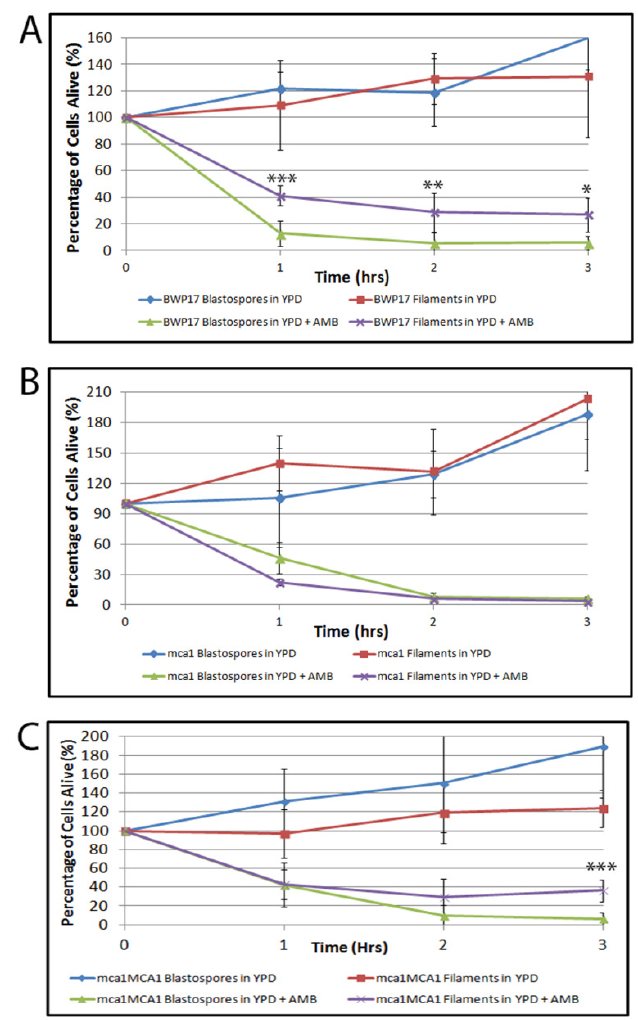
FIGURE 2: Filamentous C. albicans cells are more resistant than blastospores to AMB-induced programmed cell death in an MCA1 -dependent manner. Viability curves compare sur- vival of the following cells exposed to AMB: (A) wild type (BWP17) blastospores and BWP17 filaments induced using 10% FBS; (B) BWP17-derived ΔΔ mca1/mca1 blastospores and ΔΔ mca1/mca1 filaments induced using 10% FBS; and (C) ΔΔ m- ca1/mca1::MCA1 blastospores and ΔΔ mca1/mca1::MCA1 filaments induced using 10% FBS. Error bars indicate standard deviations for trials with at least three independent cultures. Note that after 3 hr, cells cultured in rich media without any drugs were able to grow and to divide, hence the relative via- bility levels that are greater than 100%. A single, double, and triple asterisk indicates statistical significance of p < 0.05, p < 0.005, and p < 0.0005, respectively, as compared to treated controls. Statistical significance was determined with the un- paired Student’s